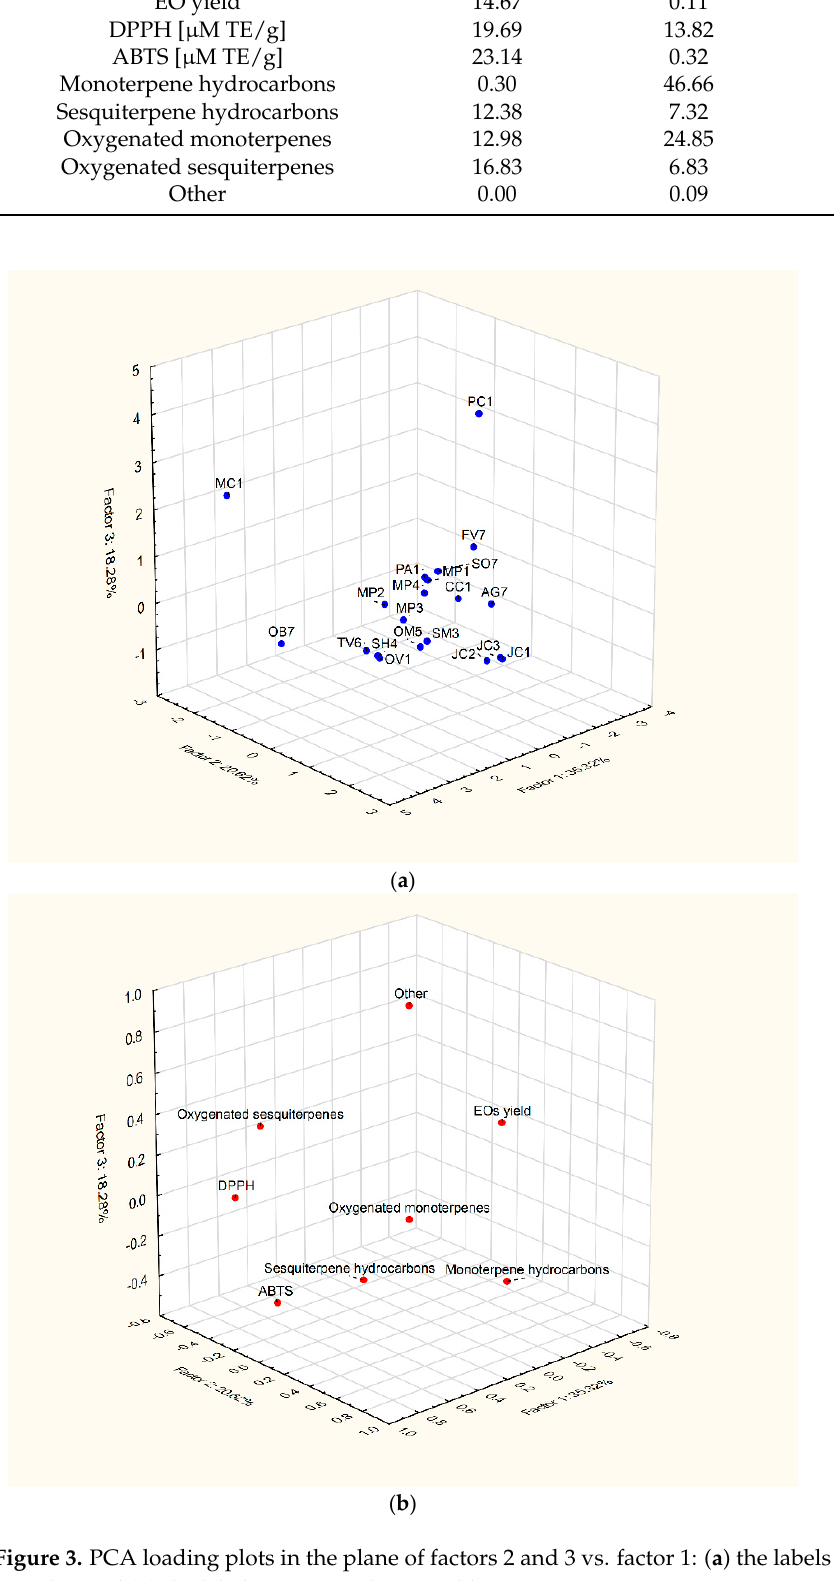
Figure 3. PCA loading plots in the plane of factors 2 and 3 vs. factor 1: ( a ) the labels correspond to samples, and ( b ) the labels correspond to variables. Table 7. Contribution of corresponding variables (%) to the first three principal components.